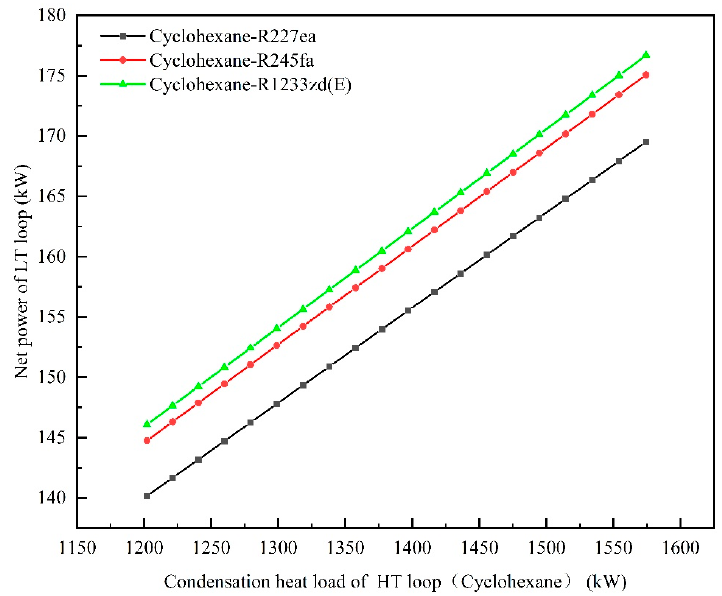
Figure 12. Net power of the LT loop with cyclohexane as the HT loop’s working fluid.